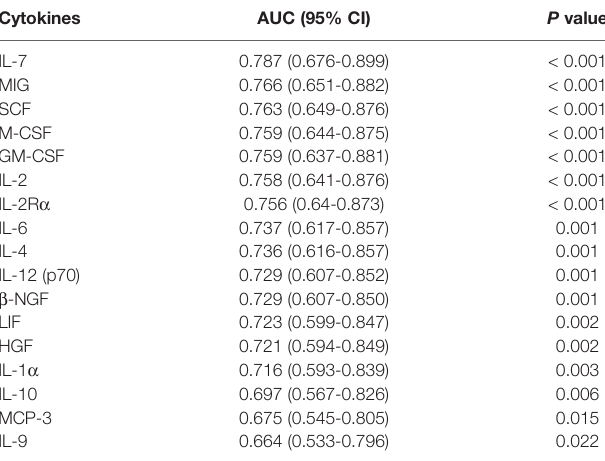
AUC: area under the curve; CI: con fi dence interval. Signi fi cant difference (P <